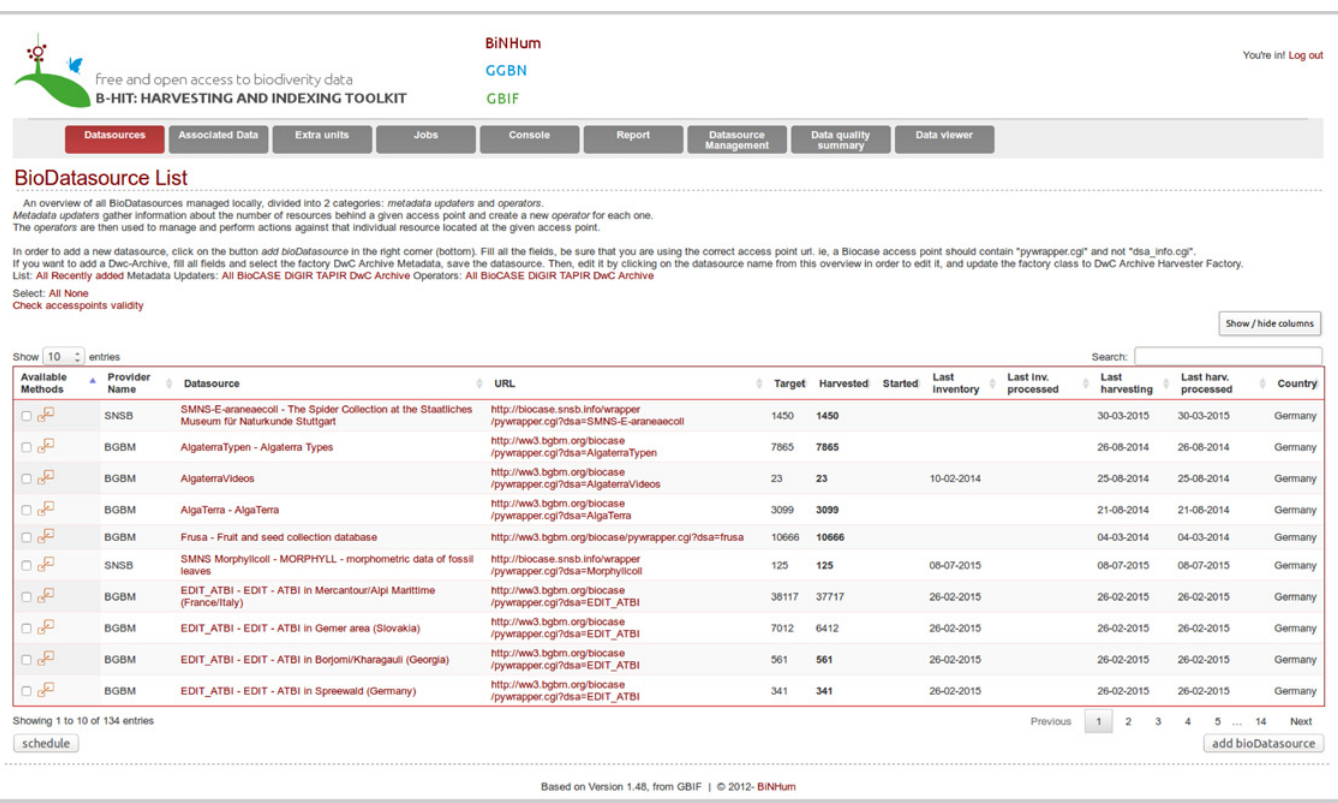
Fig 4. Web interface of B-HIT. This extended user-interface makes it possible to gain access to the new functionalities (i.e. Associated Datasource Harvesting, Data quality, Datasource Management) through a series of